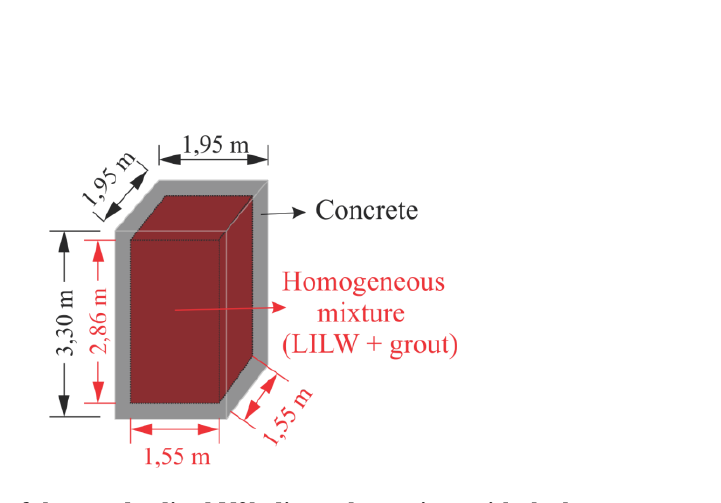
Figure. 2. The simplified model of the standardized N2b disposal container with the homogeneous mixture of LILW and grout (red) placed in the centre of the concrete construction